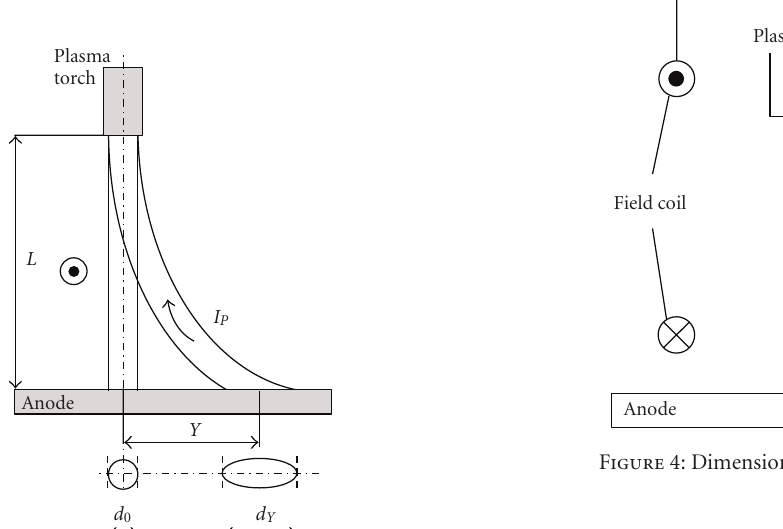
Figure 1: Schematic illustration of a system used to produce a magnetically driven arc.